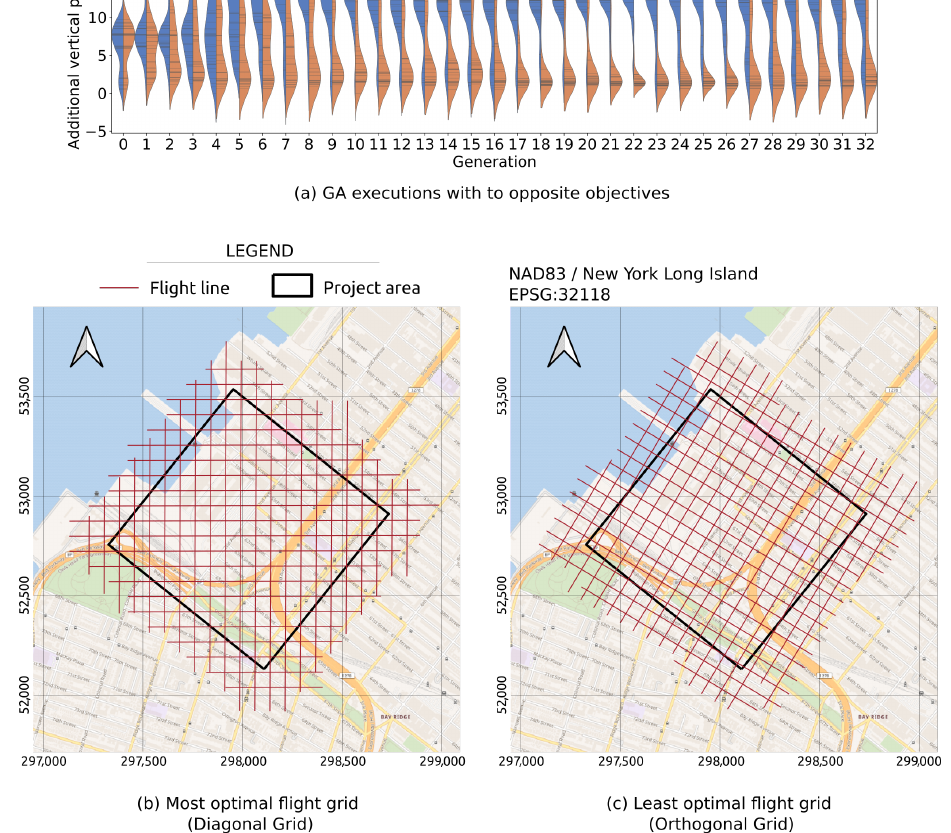
Figure 9. LiDAR flight path optimization results: ( a ) The evolution of the population fitness scores over 32 generations according to 2 opposite optimization objectives; ( b , c ) The most and least optimal flight paths derived from the GA optimization,